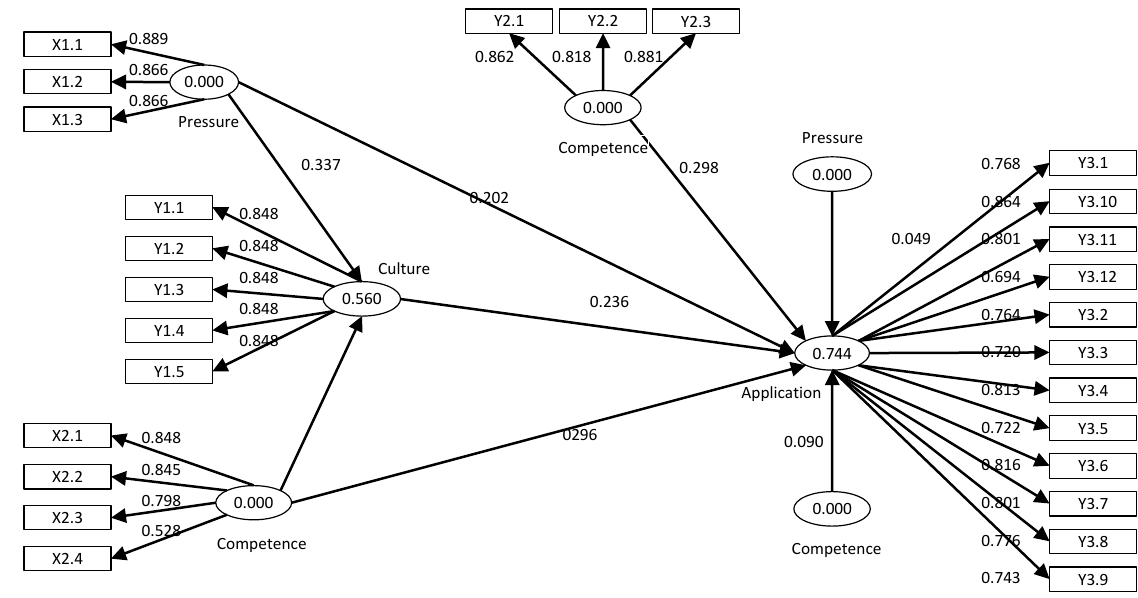
Figure 2. Result of path diagram Table 1. Results of direct effect analysis